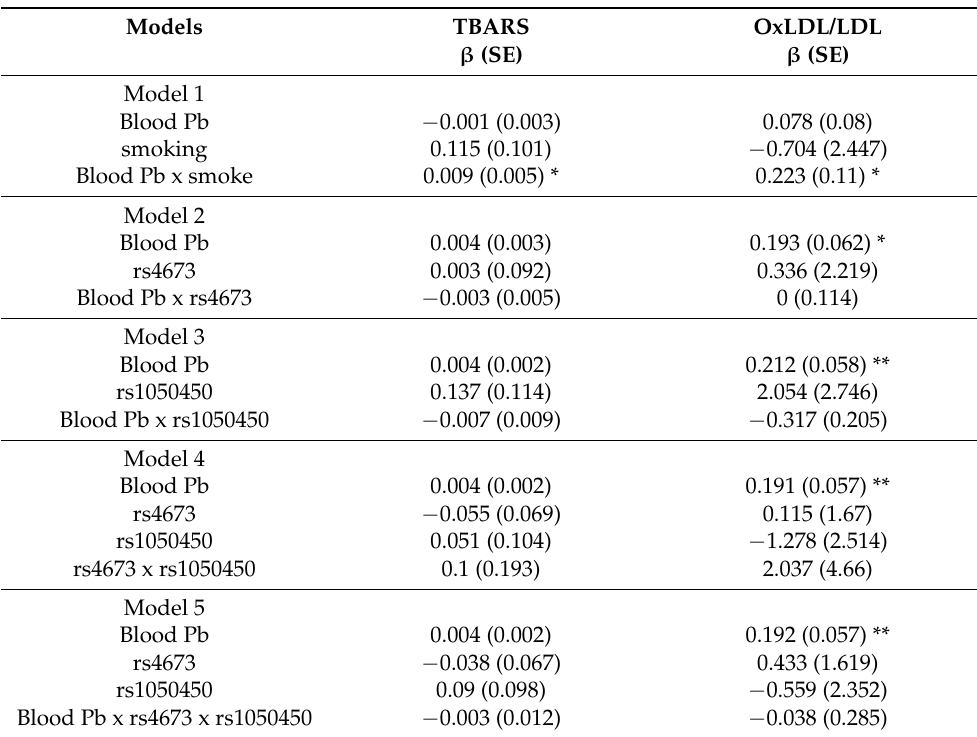
Table 3. Multiple linear regression coefficients of TBARS and OxLDL/LDL in different interac- tion